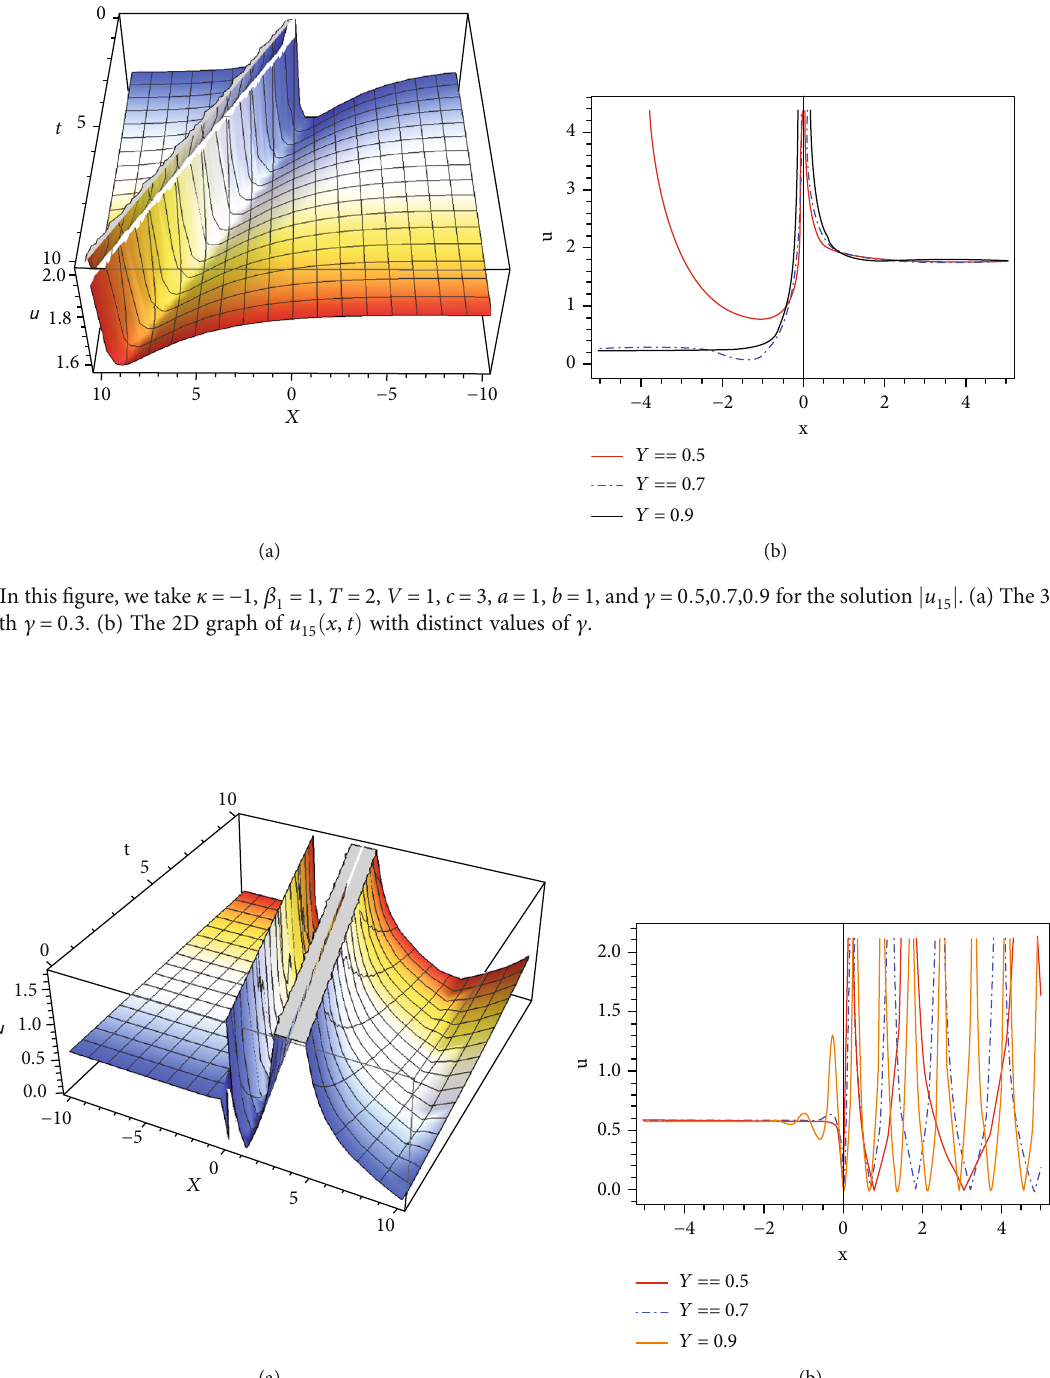
j . (a) The 3D graph of 16